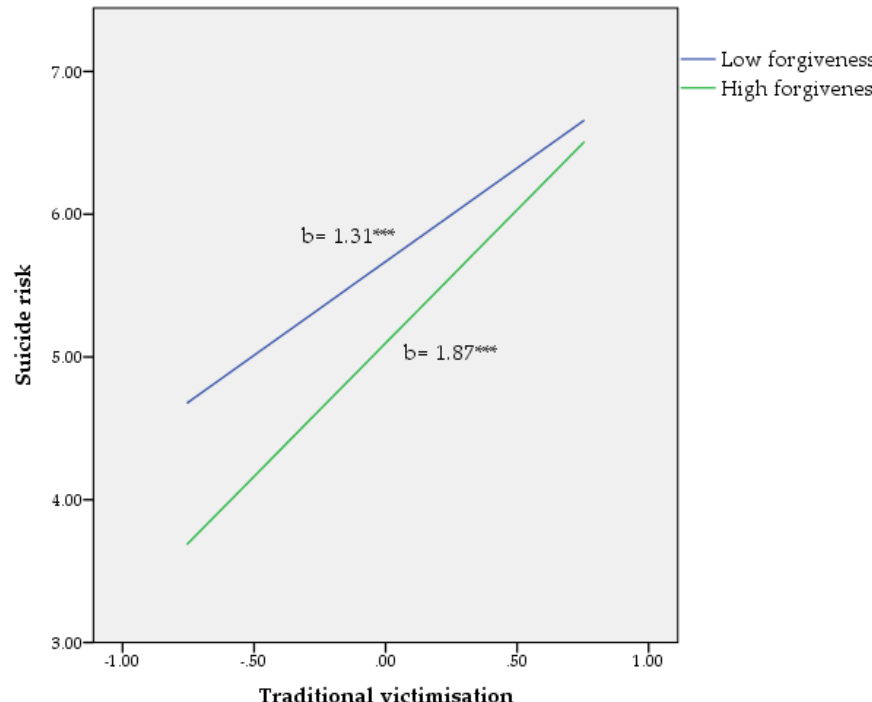
Figure 1. Relationship of traditional victimisation and forgiveness for predicting suicide risk. *** p < 0.001. Note: values for forgiveness (moderator) are the mean and plus/minus one standard deviation ( SD ) from the